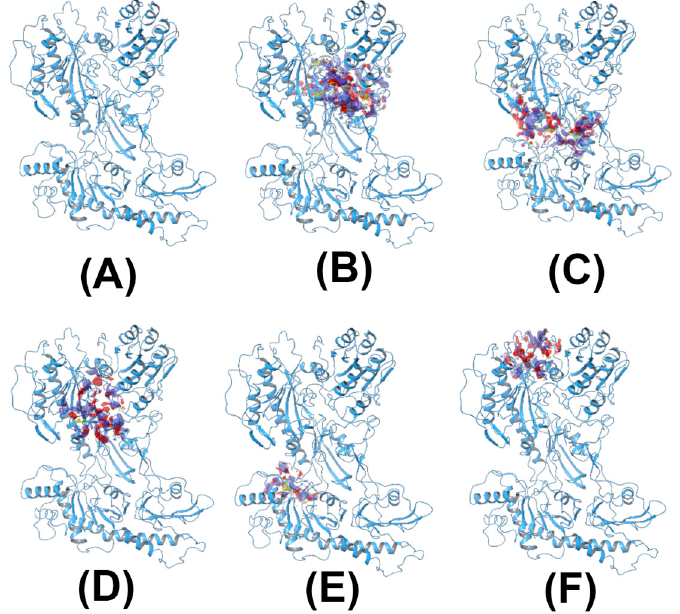
Figure 1. The homology model of CACNA2D1 ( A ) and the corresponding binding sites identified by SiteMap (( B – F ) Sites 1–5, respectively). The yellow mesh in the binding sites indicates the hydrophobic map, while the blue and red colors indicate the hydrogen-bond donor and hydrogen-bond receptor maps, respectively.